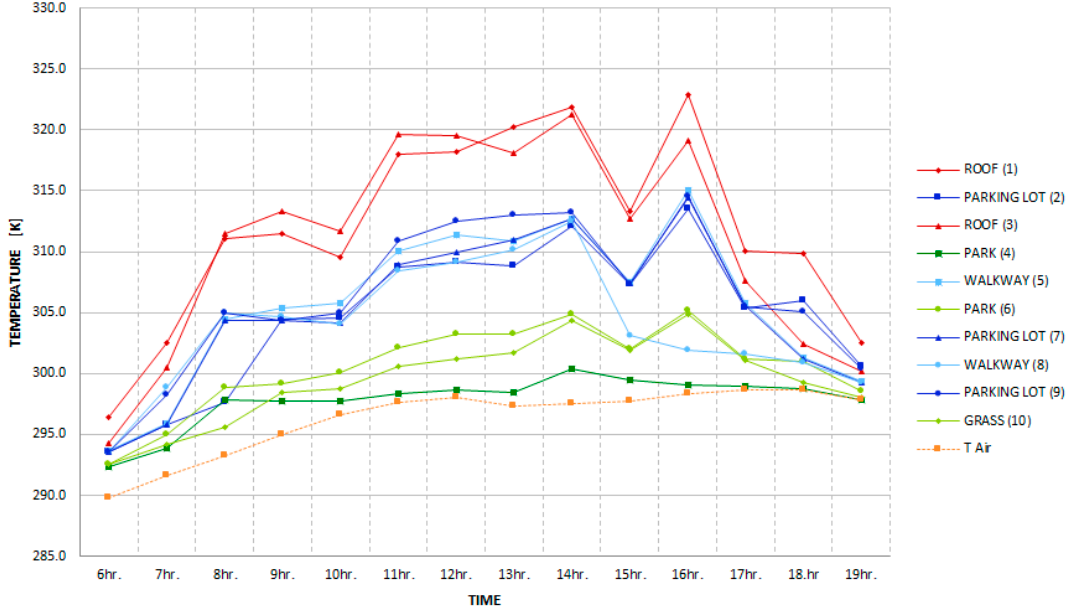
Figure 5. Simulated LSTs with heat storage effects in 10 selected locations in the study area on 25 June 2020.